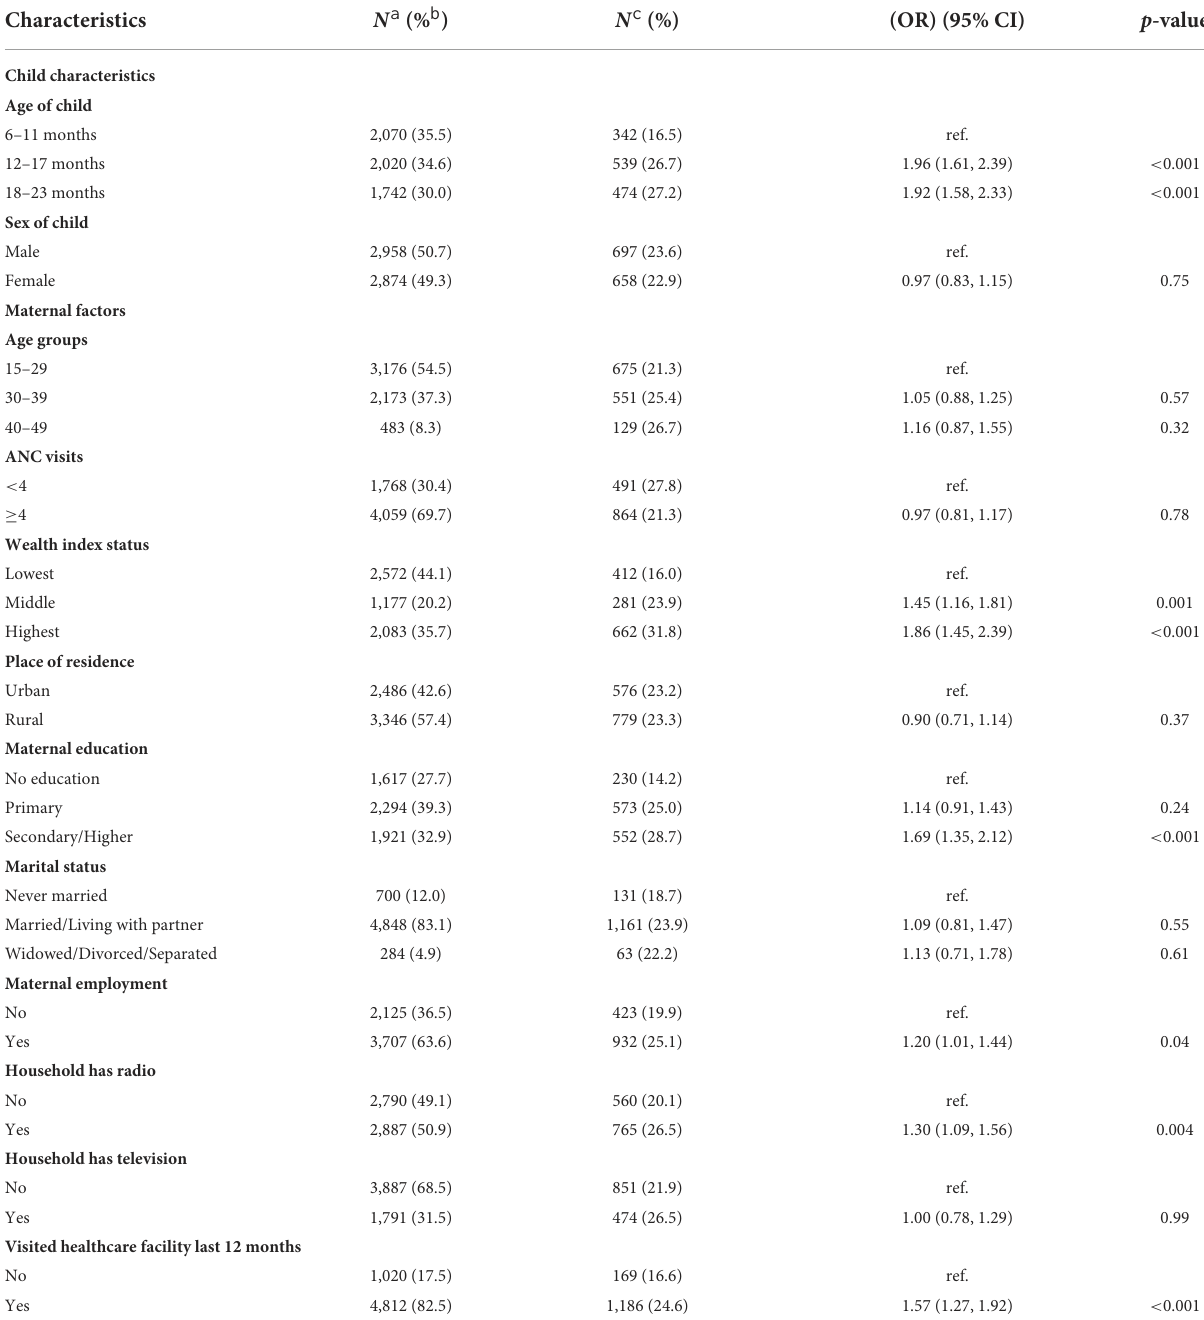
TABLE 2 Background characteristics of the weighted survey participants, the prevalence of meeting minimum dietary diversity, and the multivariable-adjusted odds ratio ( N = 5,832). All participants Minimum dietary diversity Multivariable-adjusted analysis